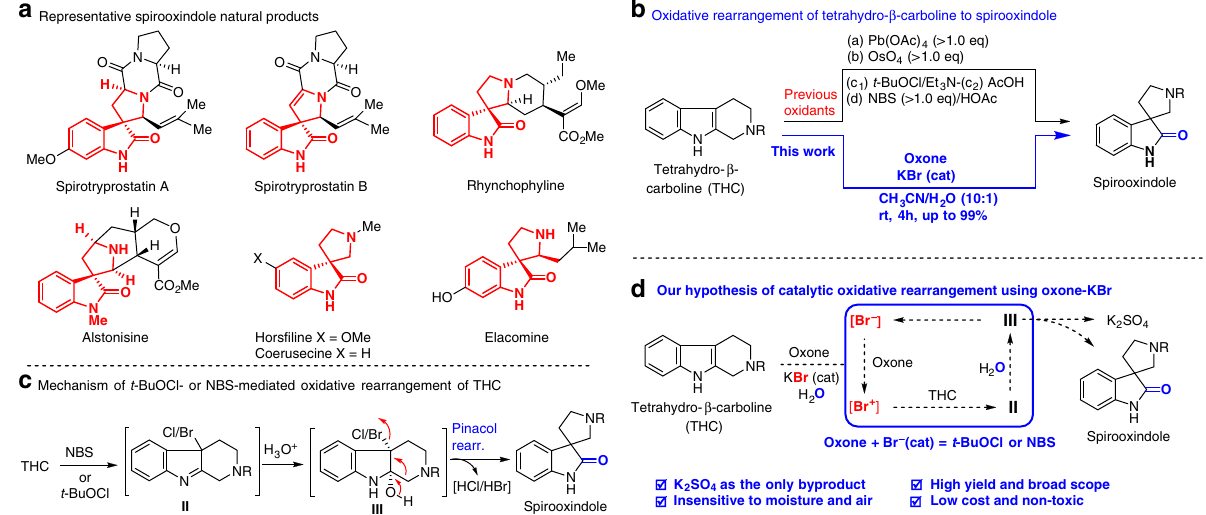
Fig. 2 Spirooxindole natural products and oxidative rearrangement of tetrahydro- β -carbolines. a Representative spirooxindole natural products. b Oxidative rearrangement of tetrahydro- β -carboline to spirooxindole. c Mechanism of t -BuOCl or NBS-mediated oxidative rearrangement of tetrahydro- β -carbolines. d Our mechanistic hypothesis of oxidative rearrangement of tetrahydro- β -carboline to